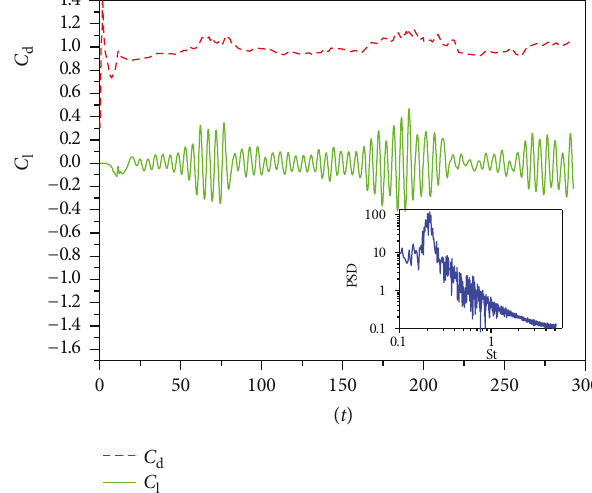
Figure 3: Time history of force coe ffi cients using ISAS model and fi ne grid (lift, C ; drag, C l d